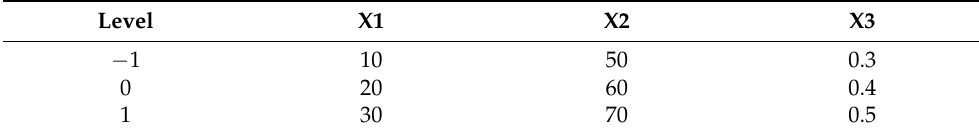
Table 3. Code and level of response surface design